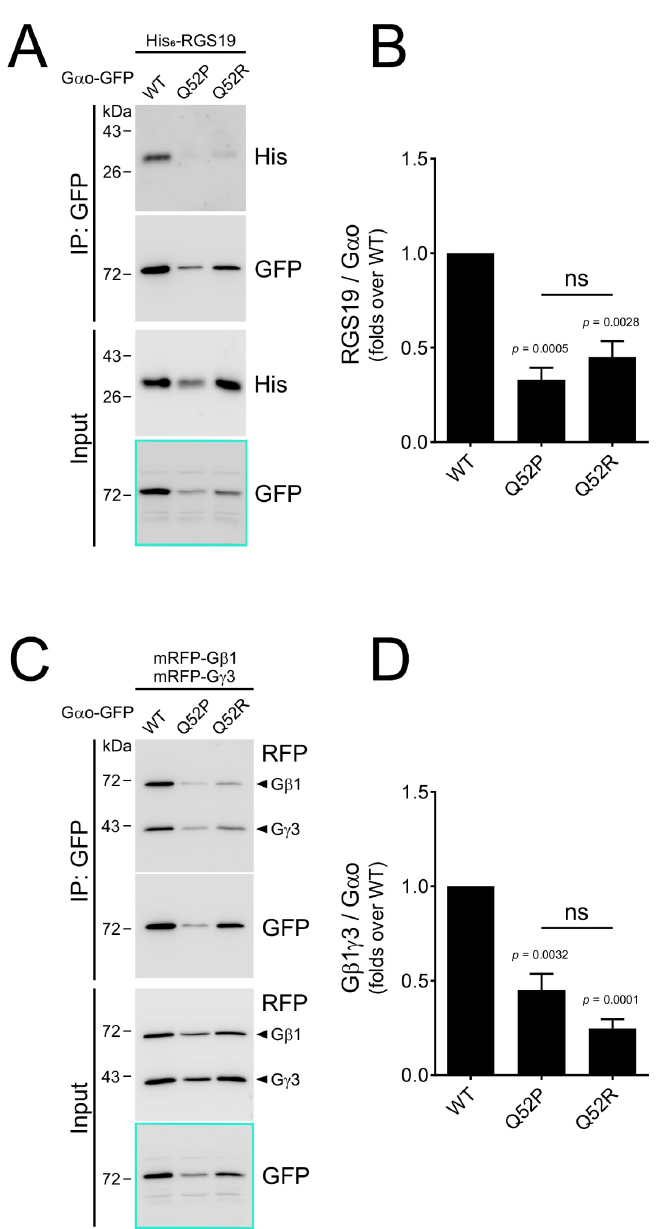
Figure 3. Pediatric encephalopathy mutations in Gln52 of G α o strongly impair the G protein interaction with its partners in N2a cells. ( A , B ) G α o-GFP wild-type (WT) and its Q52P and Q52R mutants were expressed in N2a cells together with His6-RGS19. The G α o-GFP constructs were immunoprecipitated (IP) and the co-precipitation of RGS19 was analyzed by Western blotting ( A ). Note that the expression of both Gln52 mutants is reduced compared to G α o WT (cyan box in the Input, also seen in panel ( C ). Quantification of the co-precipitation of RGS19 ( B ) normalized to the precipitated G α o. Data shown as the mean ± SEM from 5 independent experiments. ( C , D ) G α o-GFP wild-type and its Q52P and Q52R mutants were expressed in N2a cells together with mRFP-G β 1 and mRFP-G γ 3. The G α o-GFP constructs were immunoprecipitated (IP) and the co-precipitation of the G β 1 γ 3 heterodi- mer was analyzed by Western blotting (arrowheads, ( C )). Quantification of the co-precipitation of G β 1 γ 3 ( D ) normalized to the precipitated G α o as in ( B ). P-values for the statistical significance of differences to the wild-type protein are shown in ( B , D ); the differences between the two mutant proteins are insignificant (ns).